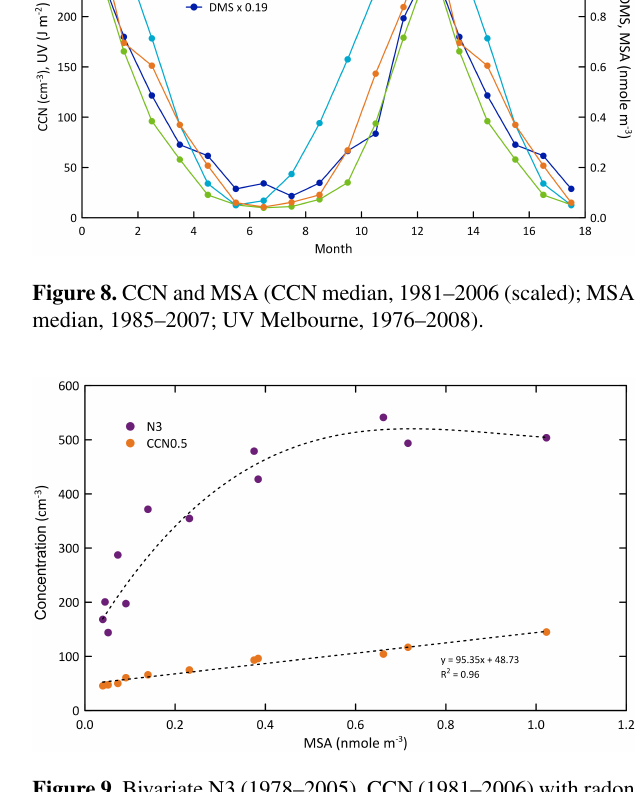
Figure 9. Bivariate N3 (1978–2005), CCN (1981–2006) with radon <150mBeqm − 3 MSA (1985–2007, monthly medians).